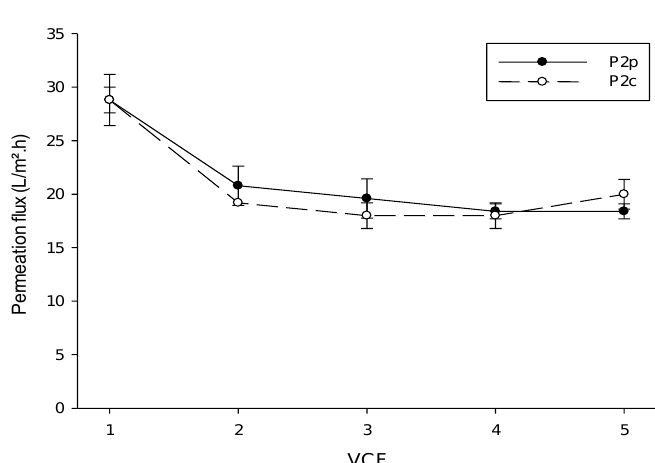
Figure 2. Permeation flux obtained during UF of control and pressure-treated egg yolk plasmas at di ff erent volume concentration factors (VCFs).